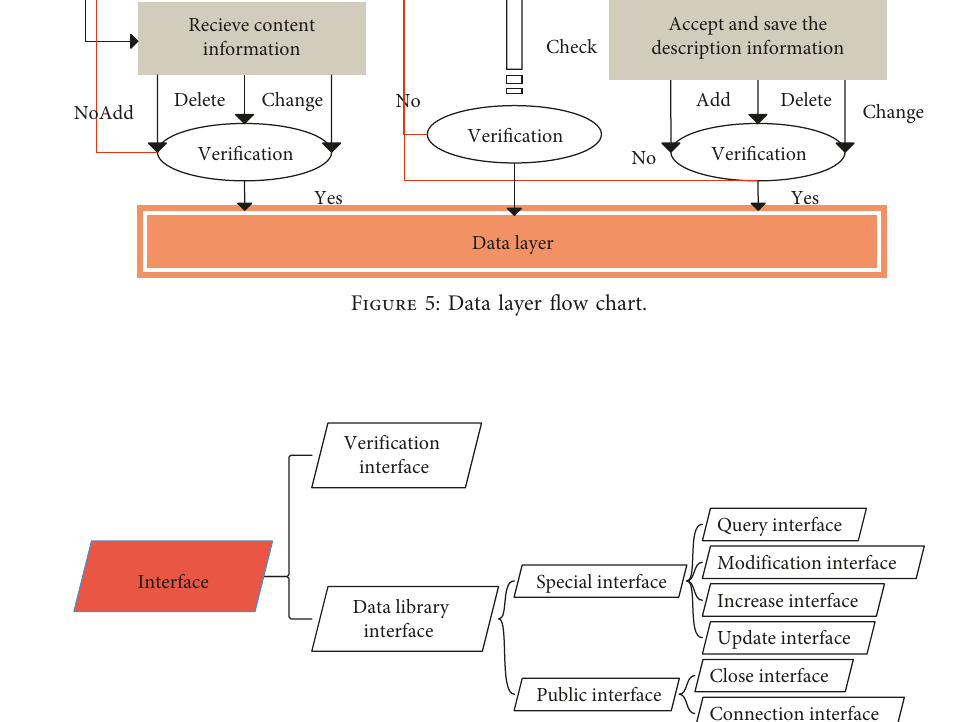
Figure 6: Data layer interface